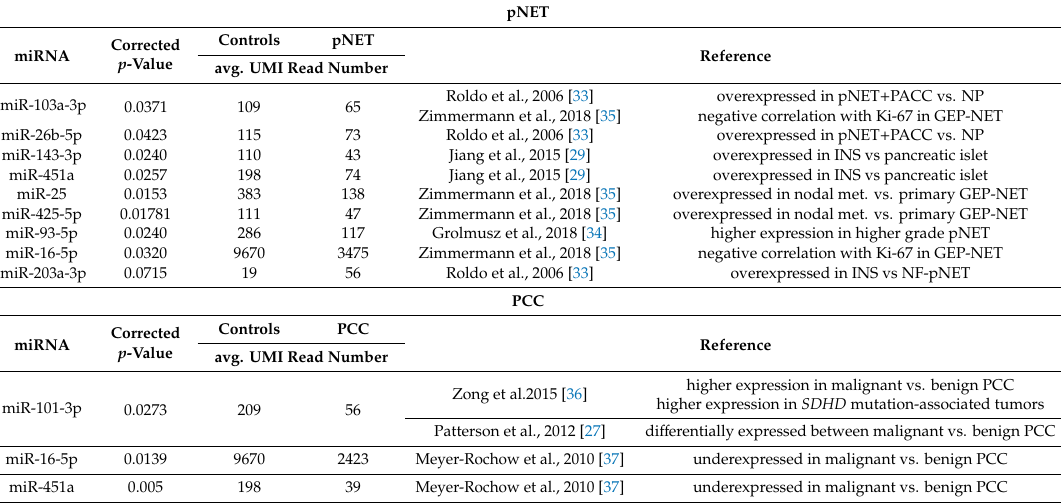
Table 4. Comparison of di ff erentially expressed miRNAs in pNET / PCC tumor tissues vs. serum. miRNAs common in both tissues and sera samples are indicated in the